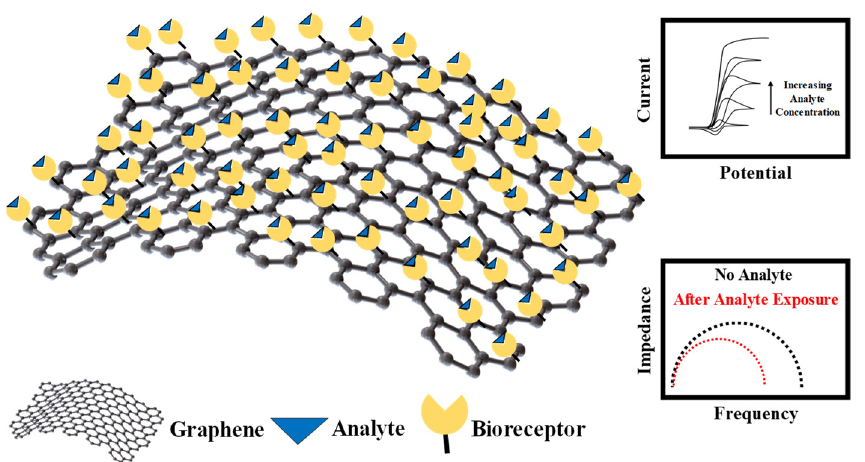
Figure 6. Schematic showing analyte capture by appropriately functionalized graphene monolayer. The capture can be electrically measured by recording the impedance properties of the graphene layer, before and after analyte capture. Additionally, cyclic voltammetry measurements of the graphene layers display a change in I-V plots as a function of analyte concentration.